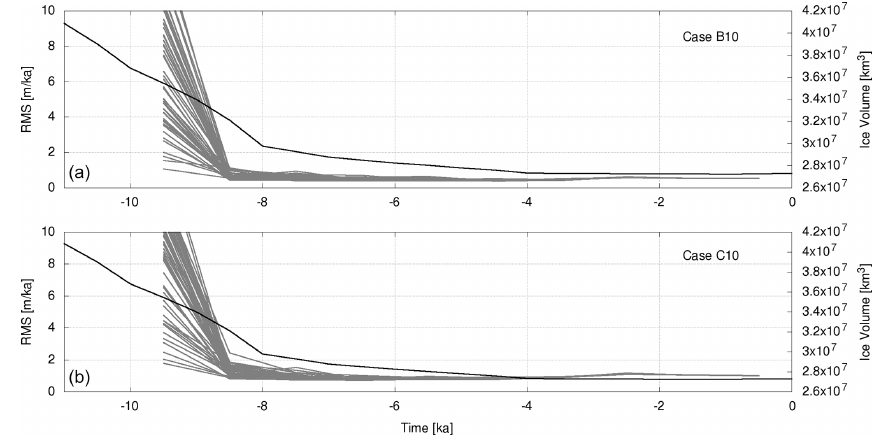
Figure 17. Measures of misfit variation for the ensemble of two sets of observations dating from after 10ka. The statistical parameters of Cases B10 and C10 are equal to those of Cases B and C in Table 2. The assumed observation uncertainties are 0.25m (a) and 0.5m (b) . Shown are the RMS values of the difference between the observations and the model predictions. The black lines show the total ice volume according to the external ice